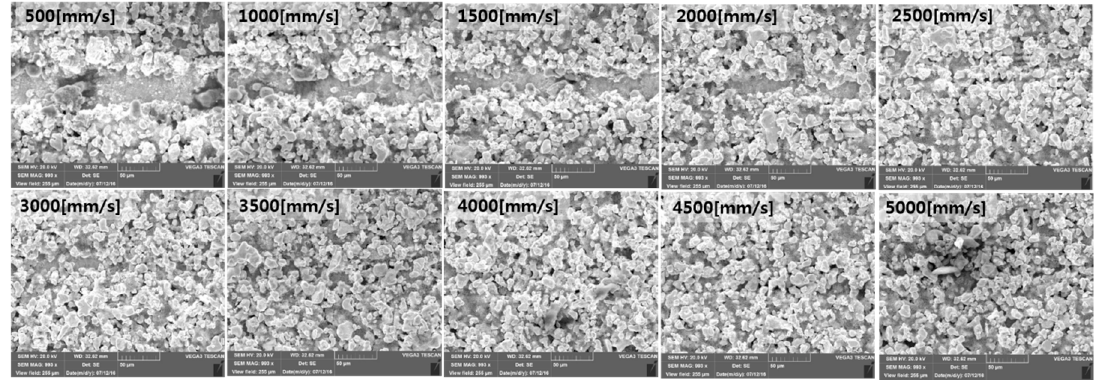
Figure 14. SEM image with a laser power of 50 W.